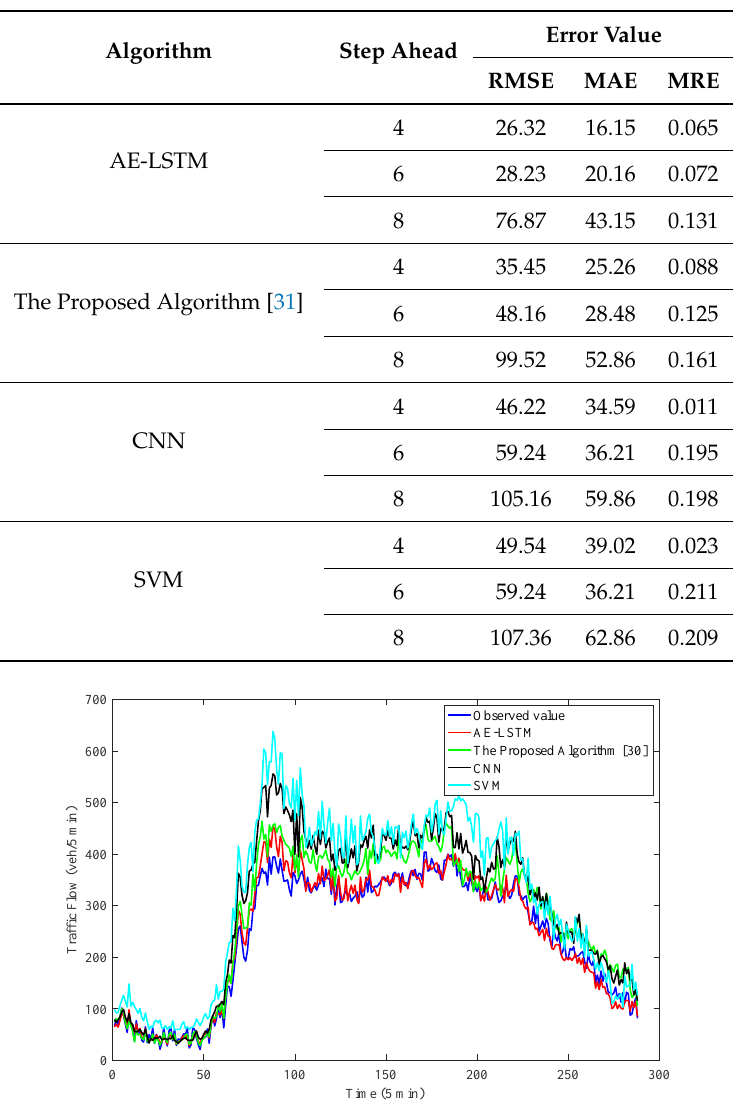
Table 2. Performance comparison.